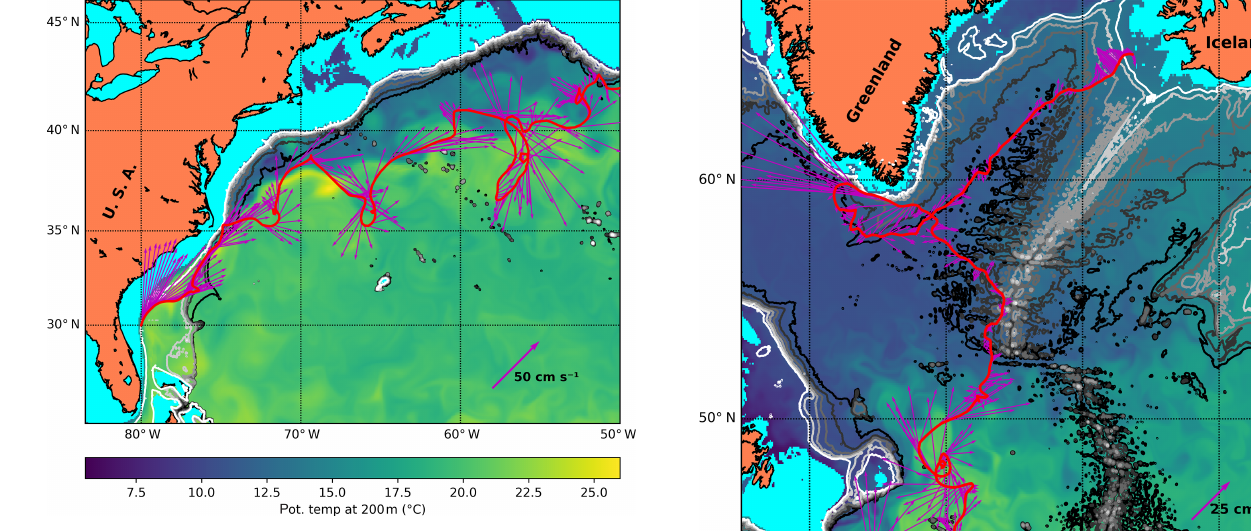
Figure 5. Slow glider in the Gulf Stream off the east coast of the USA. The glider starts at the coast of Florida at the 500m isobath. Bathymetric contours drawn at 500m intervals to 3000m. The tem- perature at 200m is also shown to represent the water mass distri- bution.